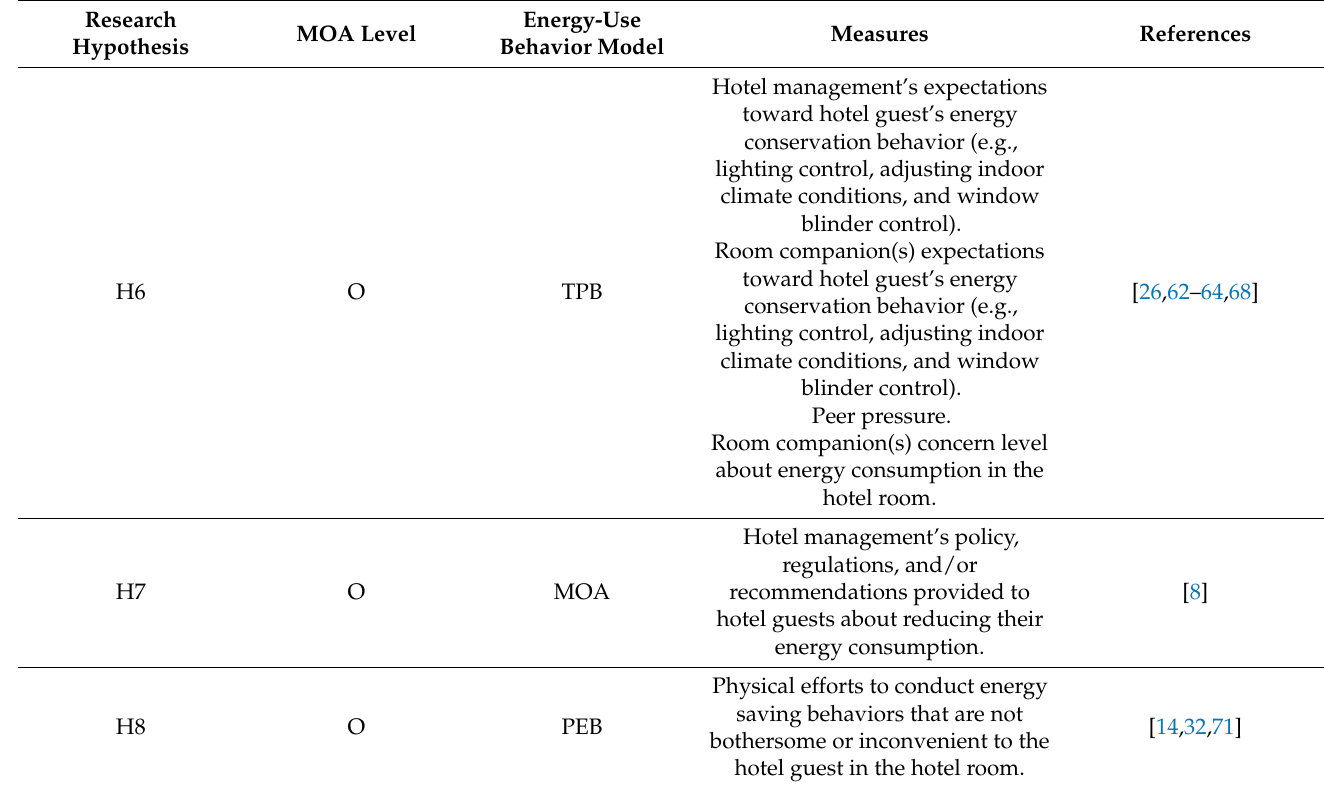
Table 2. Energy-Related Hypotheses and Measures for